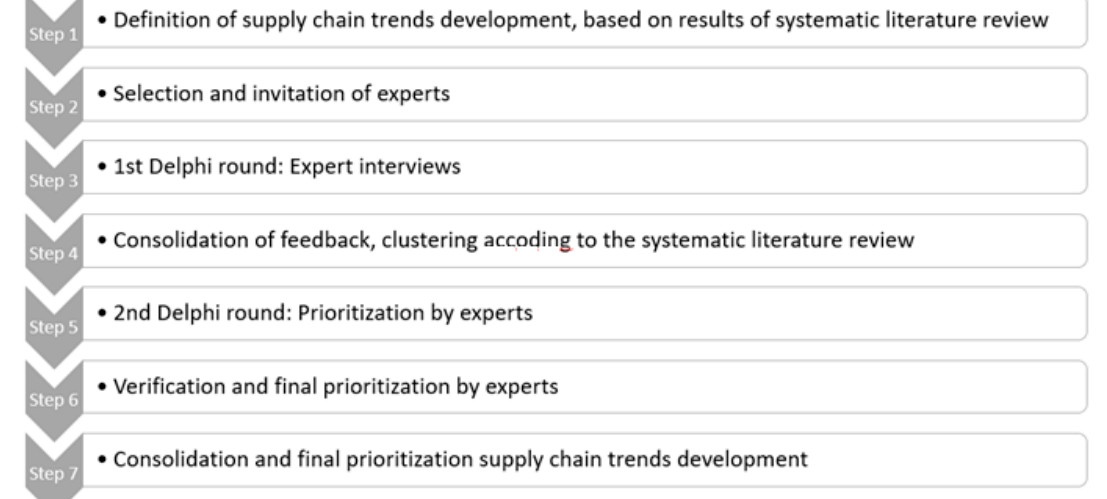
Figure 2. The structured process of the Delphi study for supply chain trends development.